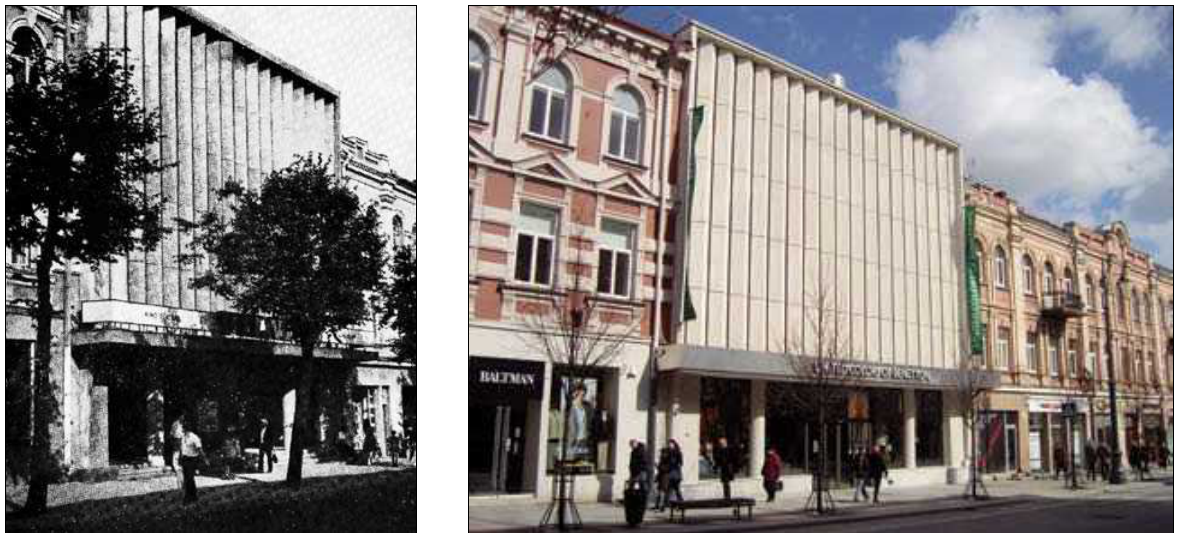
3, 4 pav. kino teatras „Vilniu­s“ Vilniu­je (arch. J. kasperavičiu­s, c. Strimaitis) 1963 m. ir dabar (3 pav. paimtas iš J. Minkevičiu­s. Architecture of the soviet Lithuania . Maskva: Stroiizdat, 1987; 4 pav. nu­otrau­ka G. Ilgūno) Figs. 3, 4. cinema “Vilniu­s“ in Vilniu­s (arch. J . kasperavičiu­s, c. Strimaitis) in 1963 and 2008